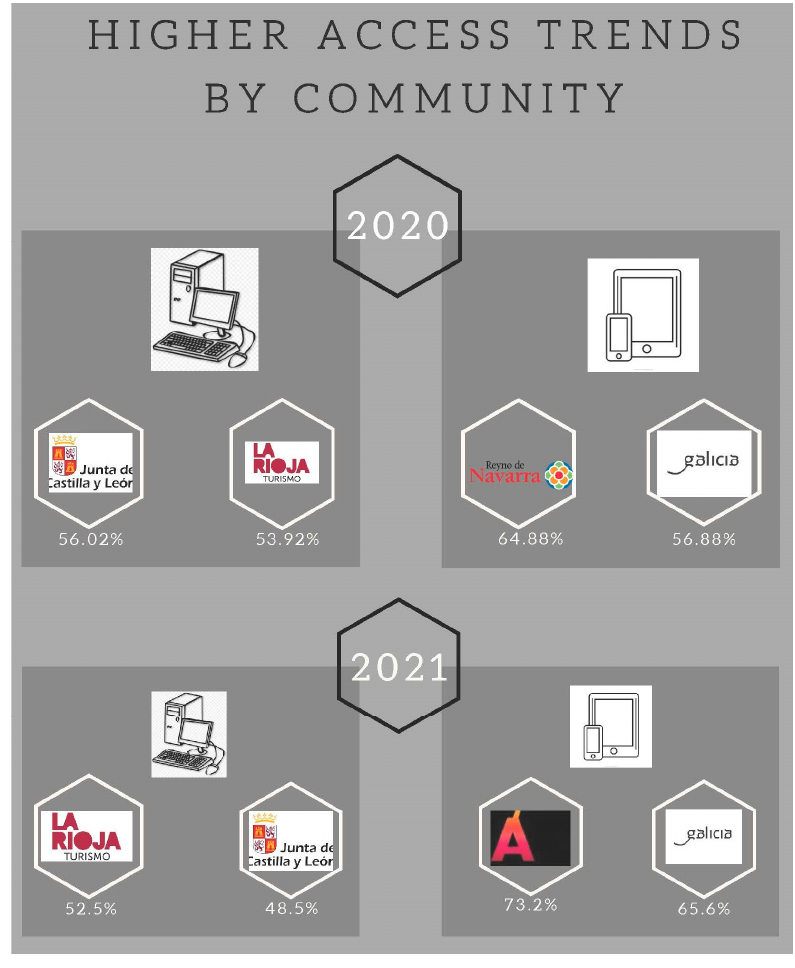
Figure 8. Access devices to the analyzed web portals 2020–2021